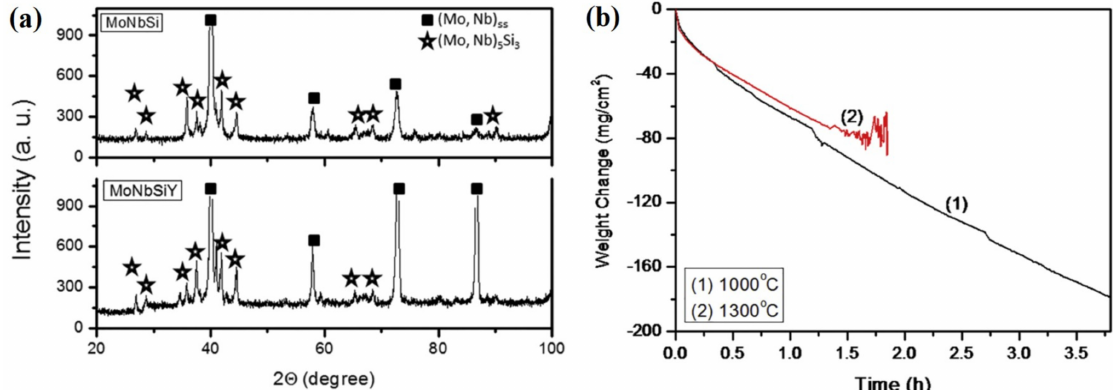
Figure 14. ( a ) XRD patterns of both samples before the oxidation; ( b ) weight change curves of Alloy2 oxidized at 1000 and 1300 ◦ C, respectively. Reproduced with permission [143]. Copyright 2018 Elsevier.